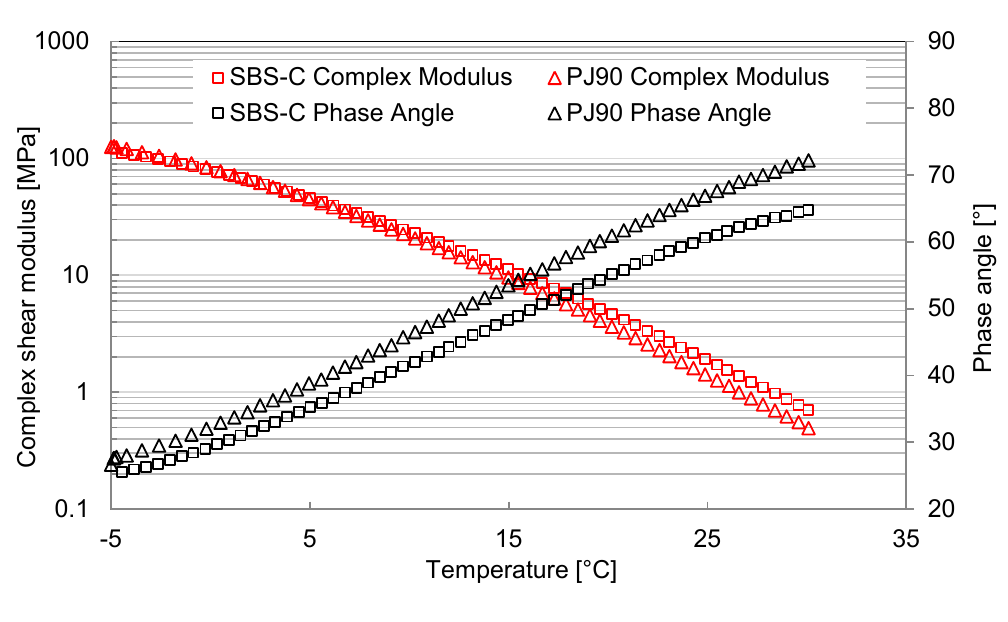
Figure 8. Phase angle and modulus curves at the lower temperature